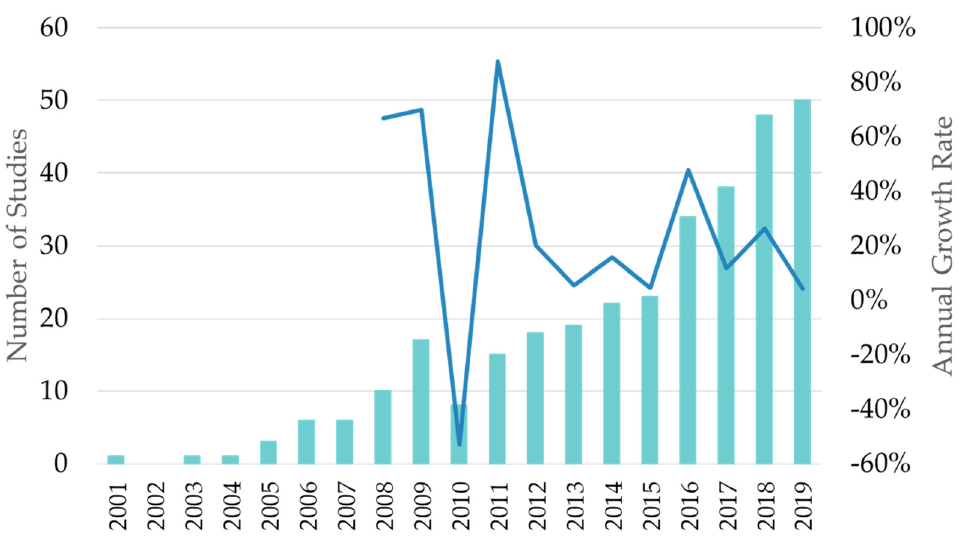
Figure 3. Number of publications per year (bar) and the annual growth rate of publications (line), not shown when number of publications was less than 10 per year.